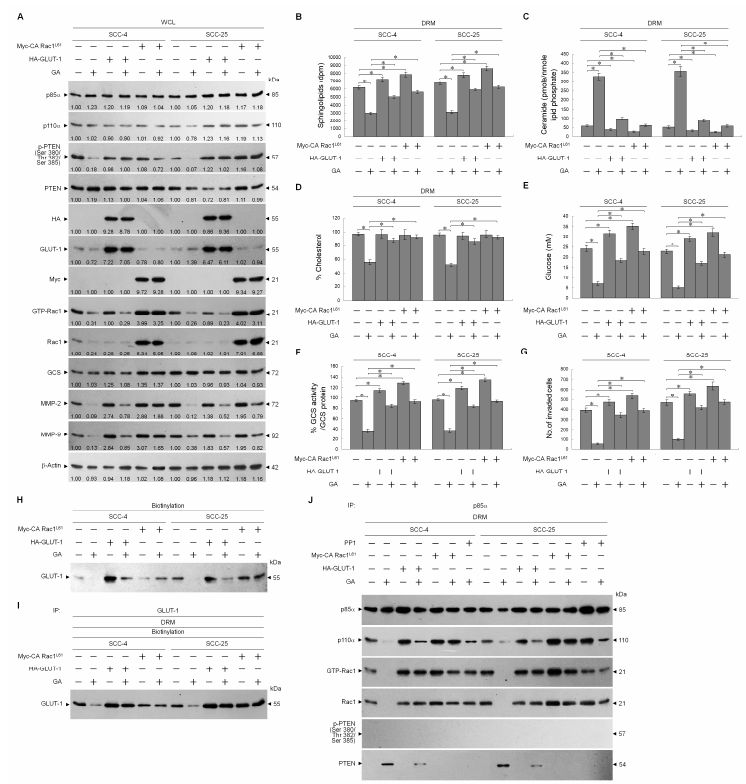
Figure 7. Ectopic expression of hemagglutinin-epitope-tagged glucose transporter-1 (HA-GLUT-1) or Myc-tagged constitutively active form of Ras-related C3 botulinum toxin substrate 1 L61 (Myc-CA Rac1 L61 ) overcomes gallic acid (GA)-induced formation of p85 α –unphosphorylated phosphatase tensin homolog deleted on chromosome 10 (PTEN) and inhibition of GLUT-1-mediated lipid raft sphingolipid homeostasis and cell invasion. At 12 h after transfection with the HA-GLUT-1-, Myc-CA Rac1 L61 -expressing plasmids or empty vector control, the cells were treated with vehicle, GA (20 µ M), or 1-(1,1-dimethylethyl)-3-(4-methylphenyl)-1H-pyrazolo[3,4-d]pyrimidin-4-amin (PP1) (6 µ M) for an additional 36 h. ( A ) The levels of the indicated proteins in the cell lysates were determined by Western blot analysis with specific antibodies. β -Actin was used as an internal control for sample loading. The values above the figures represent relative density of the bands normalized to β -Actin. ( B – F ) The lipids were extracted from the DRM fractions, and cholesterol, sphingolipid, and ceramide were quantitated by Amplex Red Cholesterol Assay Kit and thin-layer chromatography, respectively. Ceramide concentrations were normalized to phospholipid phosphate. The value of cellular glucose was analyzed using glucose assay kit. Acid sphingomyelinase (ASM) activity was determined by Acidic Sphingomyelinase Assay Kit. Glucosylceramide synthase (GCS) activity was measured by addition of NBD-ceramide via thin-layer chromatography (TLC) separation. The values are presented as the means ± standard error (S.E.M.) of three independent experiments. * p < 0.05: significantly di ff erent from vehicle ( − ) or GA-treated cells. ( G ) The invaded cell numbers were assessed by the Matrigel invasion assays. The values are presented as the S.E.M. of three independent experiments. * p < 0.05: significantly di ff erent from vehicle ( − ) or GA-treated cells. ( H ) Biotinylated proteins were pulled down using streptavidin agarose beads. The biotin-streptavidin complexes were immunoblotted with GLUT-1 antibody. ( I ) The GLUT-1 antibody used for co-immunoprecipitation of cell surface-biotinylated protein from the detergent-resistant membrane (DRM) fractions is indicated at the top of the figure. ( J ) The p85 α antibodies used for co-immunoprecipitation are indicated at the top of the figure. The proteins in the immunoprecipitated complexes from the DRM were analyzed by Western blot using specific